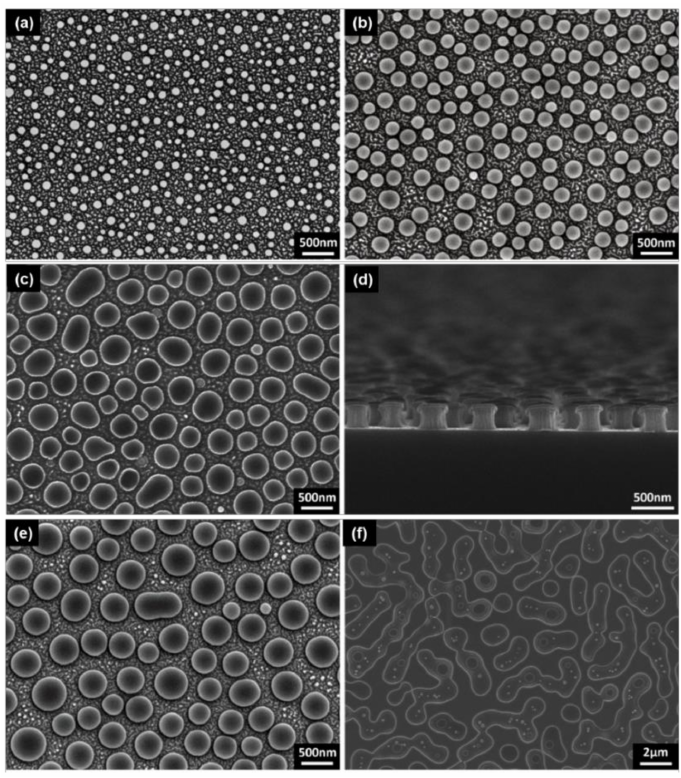
Figure 1. SEM images of different structures formed after phase separation and O 2 RIE process with the PPSQ/PS ratio vary from ( a ) 1:4, ( b ) 2:3 to ( c ) 1:1. ( d ) cross-sectional SEM images the PPSQ nanopillars formed in ( c ) after removing the continuous PS phase and PPSQ remnants at 5 wt% concentration with PPSQ/PS ratio of 1:1. SEM images of different structures formed after phase separation and O 2 RIE process with the PPSQ/PS ratio vary from ( e ) 3:2 to ( f ) 4:1 under the same experimental conditions of concentration (5%) and spin speed(3000 rpm). Note: the flocculent substance in micrographs is a few PPSQ remnants at the bottom. Table 1. Summarization of feature size distribution and area fraction of PPSQ nanopillar structures with various PPSQ/PS ratios and solution concentration of 5wt%. The number of particles and intervals counted is 150 for each sample. PPSQ/PS Weight